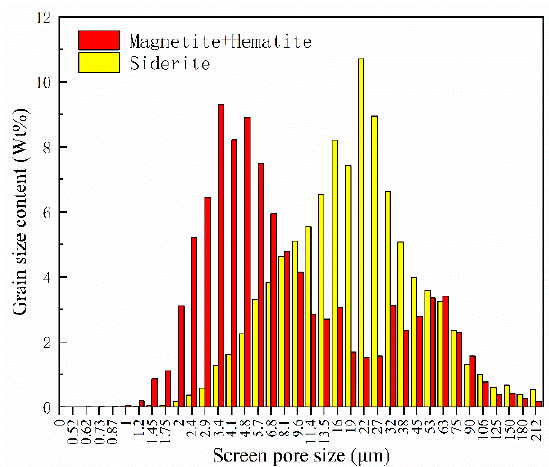
Figure 5. The particle size distribution characteristics of M/H and siderite in the tailing. Table 3. The statistical result of particle size distribution.